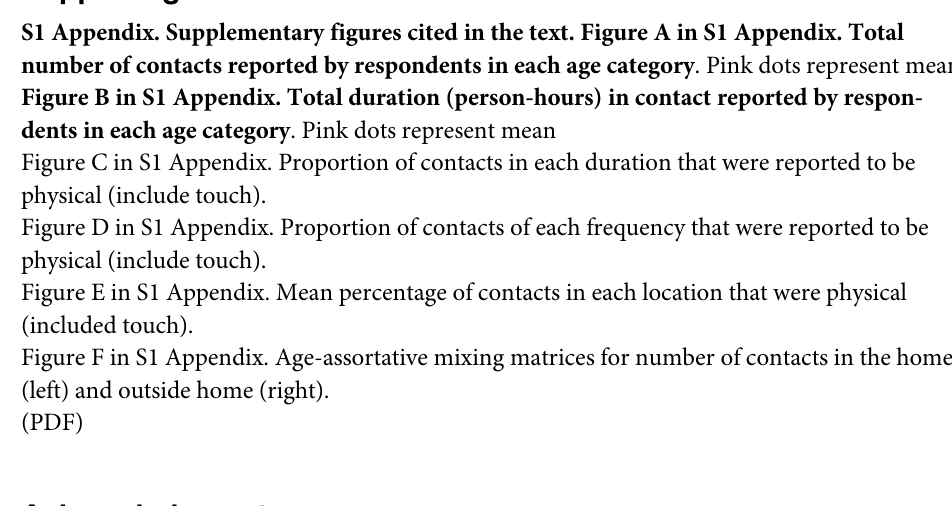
Figure E in S1 Appendix. Mean percentage of contacts in each location that were physical (included touch). Figure F in S1 Appendix. Age-assortative mixing matrices for number of contacts in the home (left) and outside home